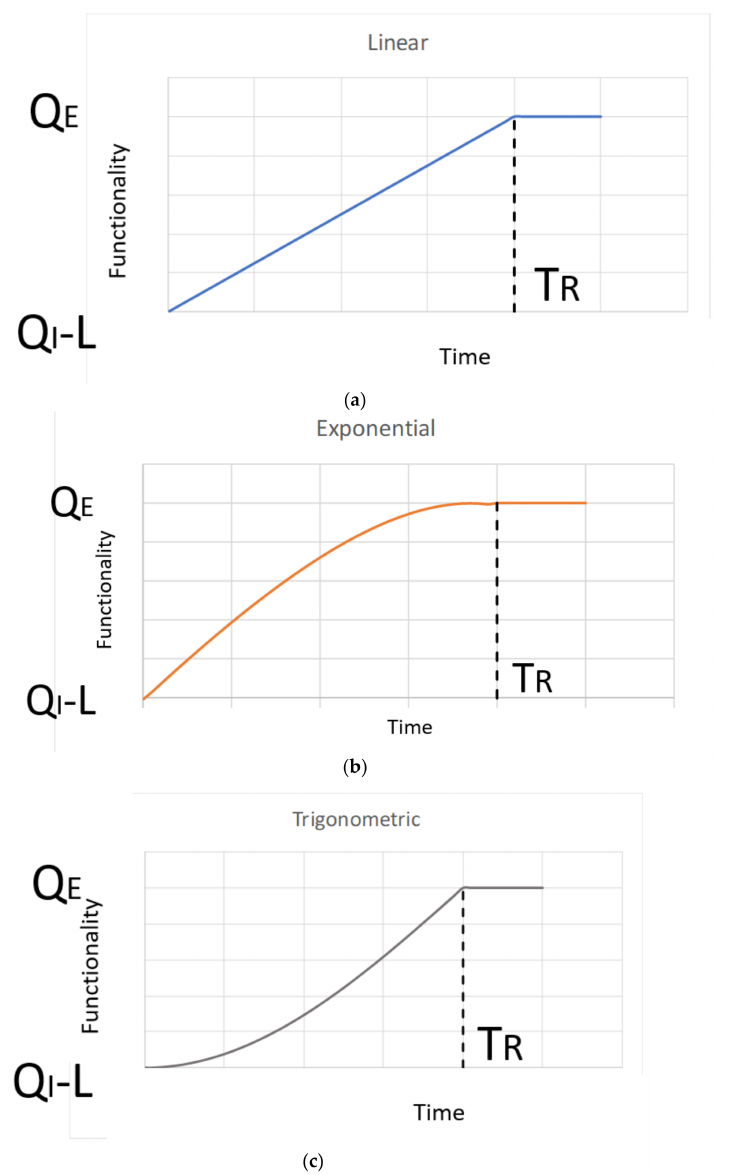
Figure 1. ( a )Recoverymodel(linear); ( b )recoverymodel(exponential); ( c